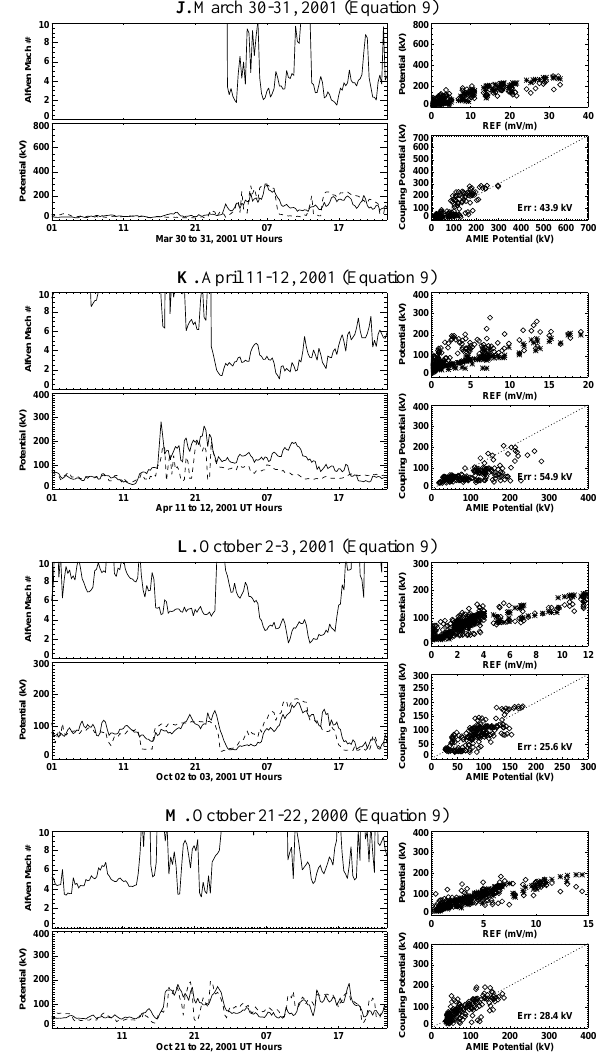
Fig. 14. The same four events in Fig. 4, plotted in the same way as Fig. 11.